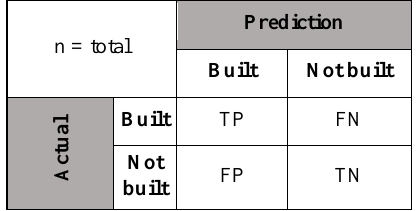
Table 1. Contingency table for the proposed methodology